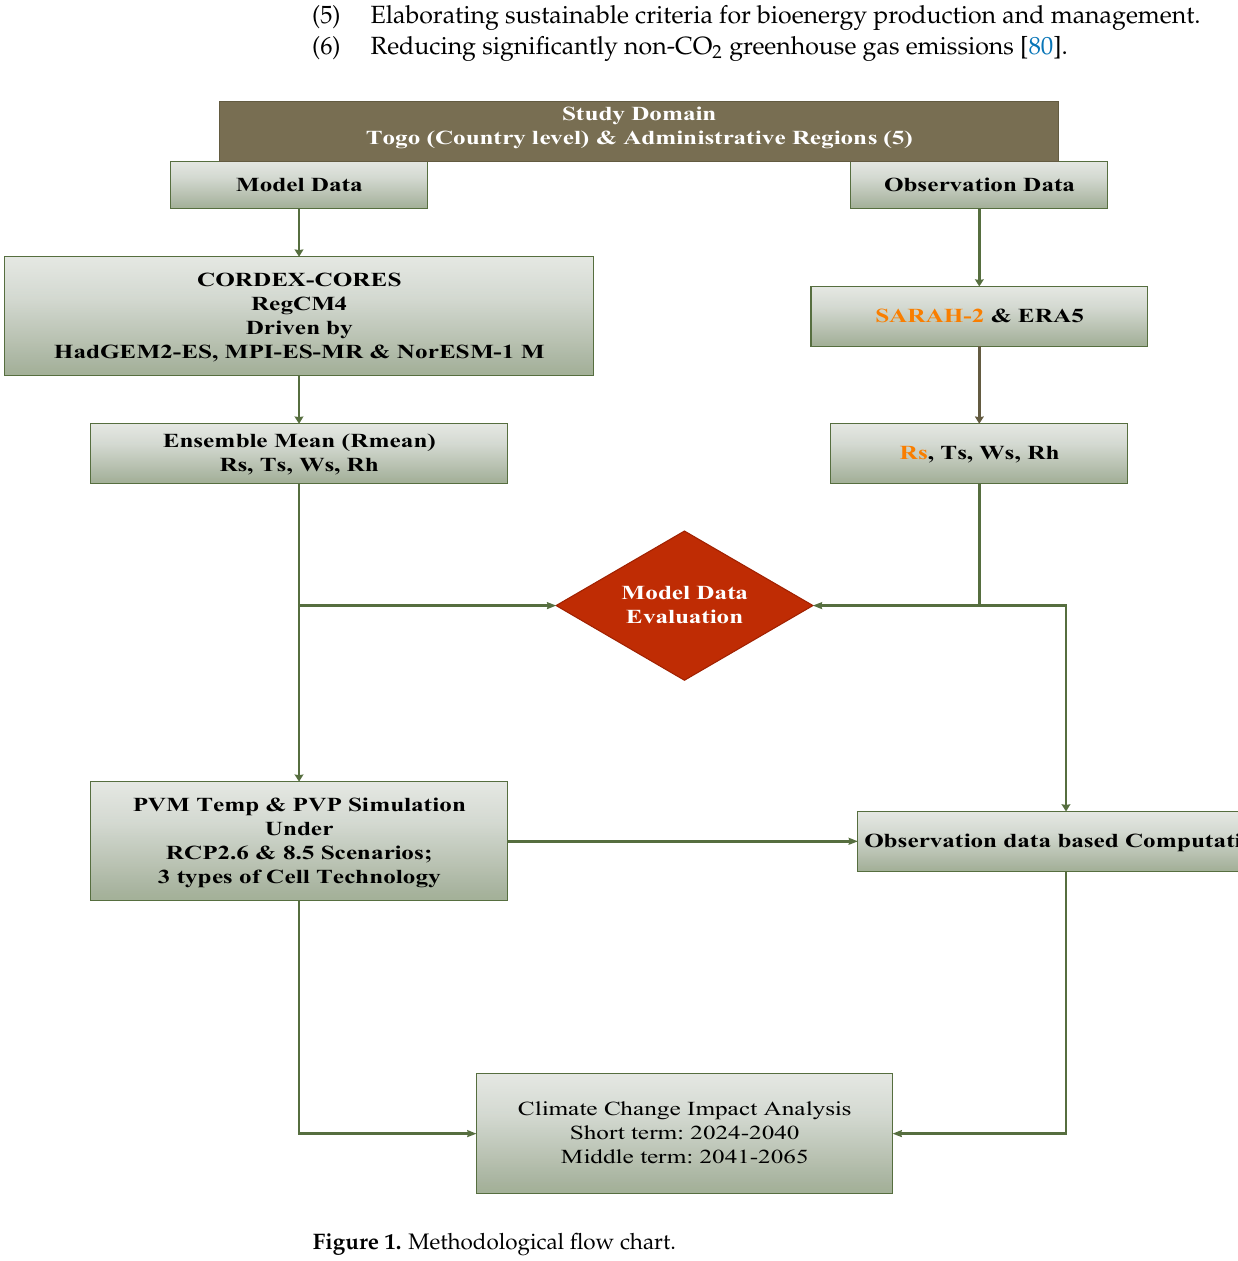
Figure 1. Methodological flow chart .